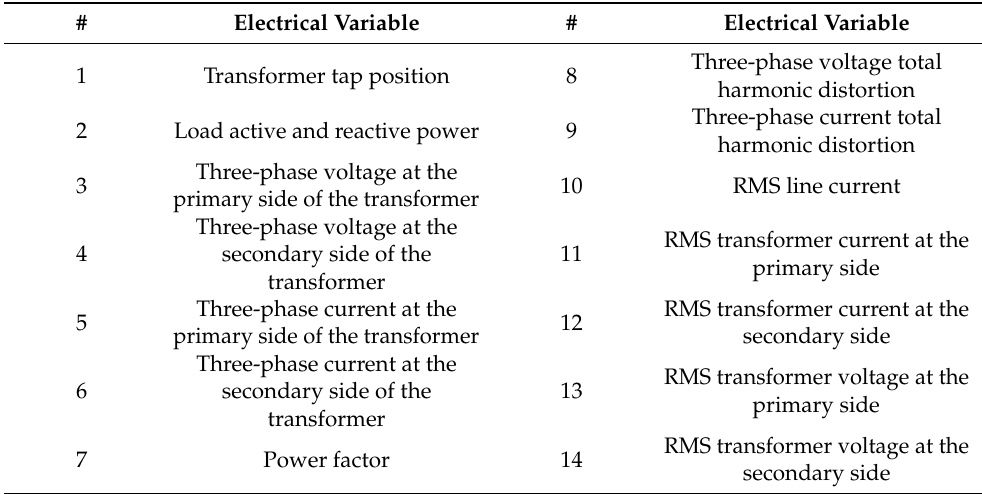
Table 1. Transmitted electrical